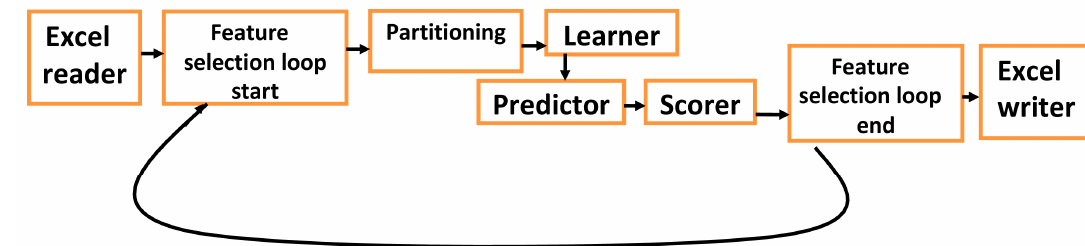
Figure 4. Suggested an e ffi cient platform for medical databases with big data (large number of inputs (features)), which include clinical, demographic, socioeconomic and genetic factors. The platform starts with feeding a data set imported from the corresponding medical database. Genetic algorithm loop randomly selects di ff erent subsets (chromosomes) of feature to use them in the prediction process, it starts with “feature selection start” and ends with “feature selection end”, and this algorithm saves time in analyzing large databases. Partitioning divides data into training and testing sets, and the scorer evaluates the prediction accuracy for the testing set, the results for di ff erent chromosomes (subsets of features) can be exported and saved as output file (i.e., excel sheet). Di ff erent learners and